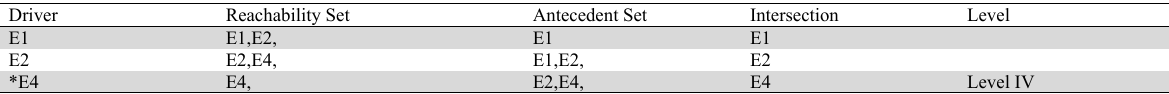
Level Partition-iteration 4